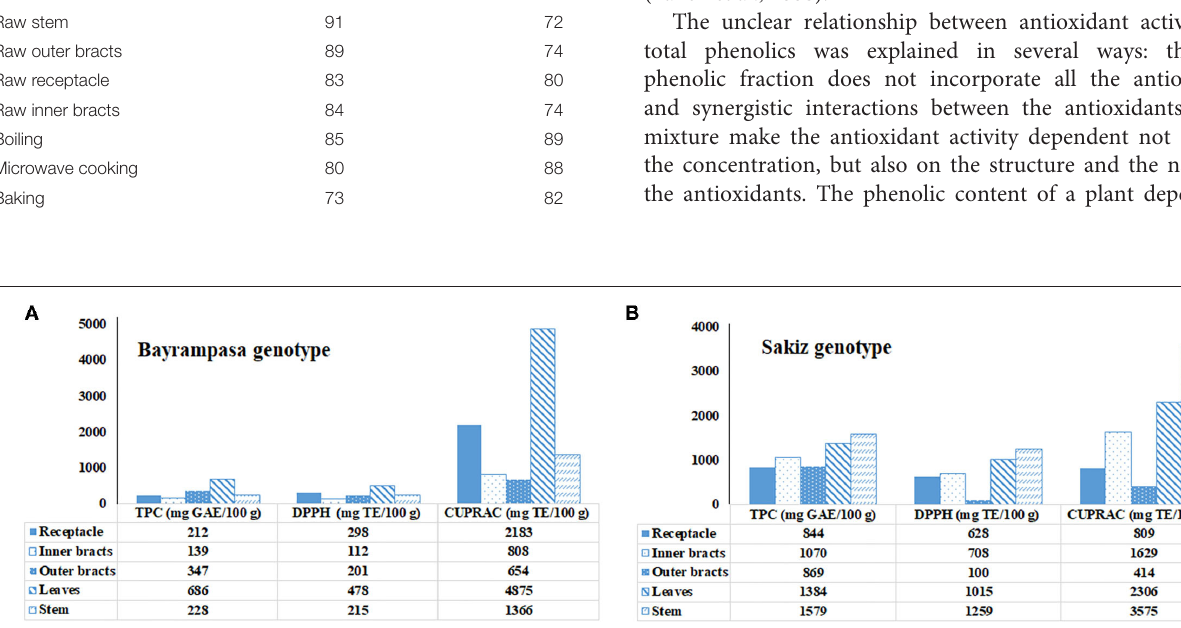
Frontiers in Sustainable Food Systems |